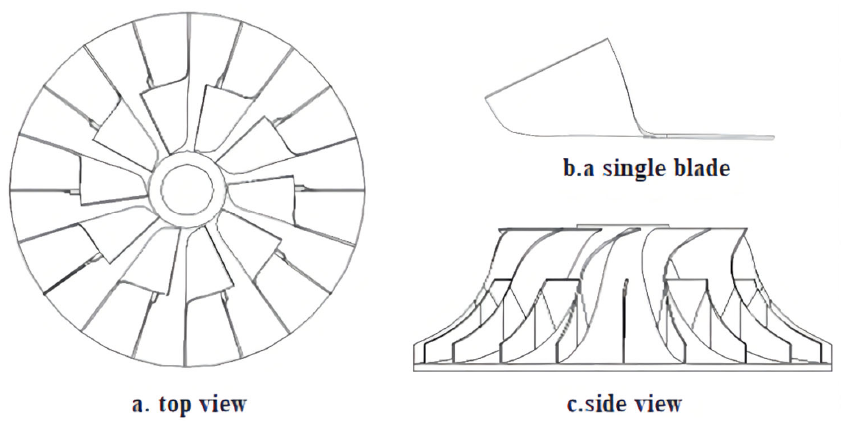
Figure 2. Blade configuration of type